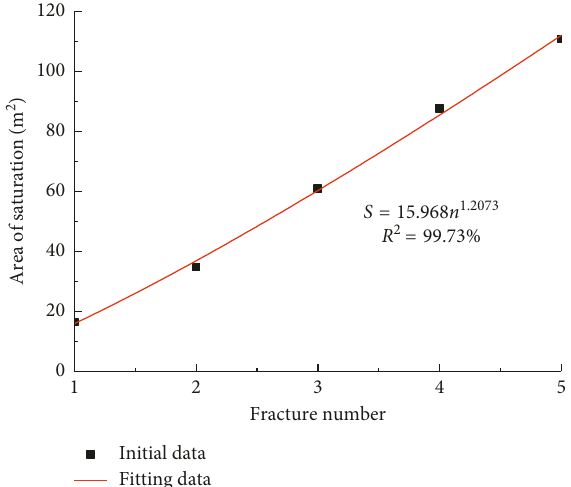
Figure 13: The relationship between the fracture numbers and the area of